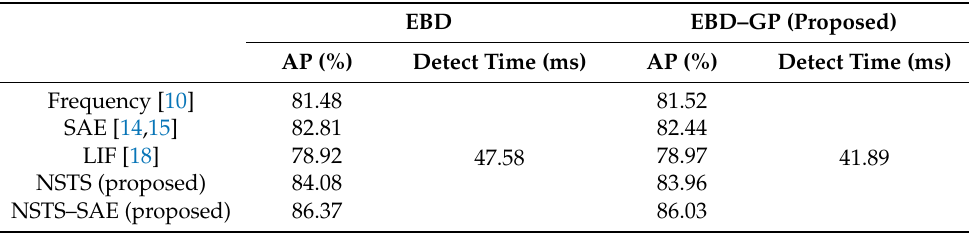
Table 3. The performance comparison of pedestrian detection accuracy and detection speed of event frames constructed by different encoding methods evaluated by EBD (event-based detector) and EBD–grid partition (GP), respectively (IOU0.5 AP).